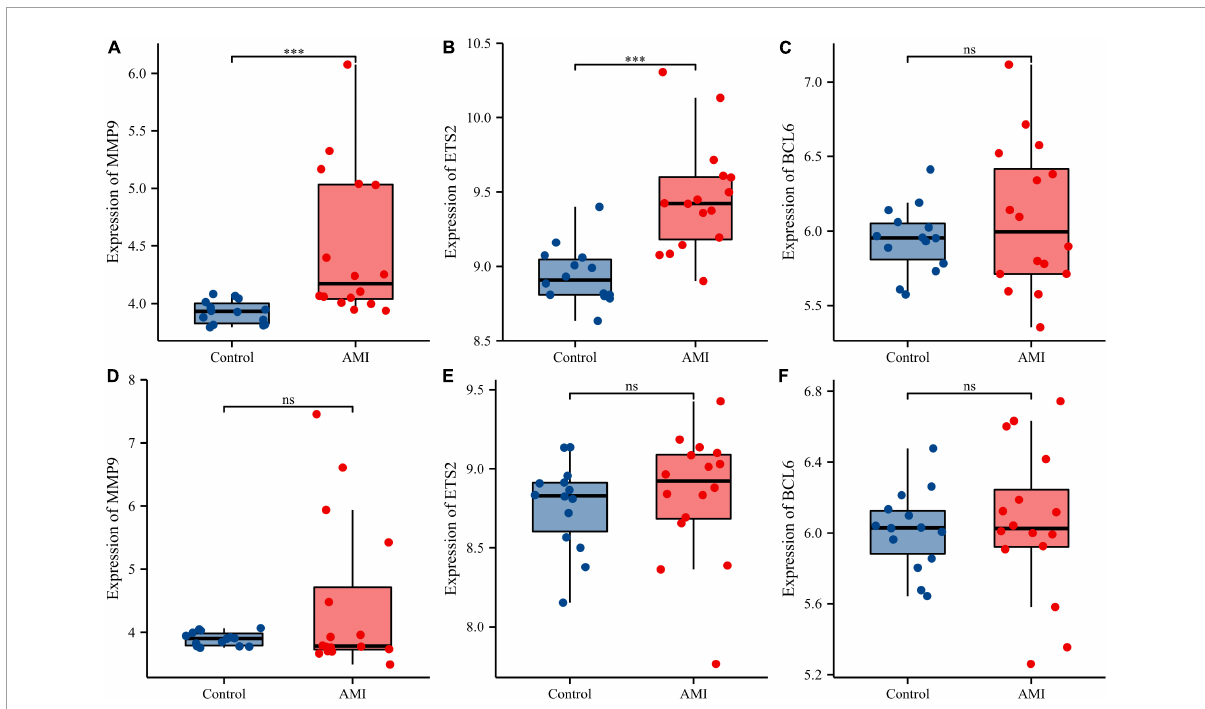
FIGURE13 Comparison of the expressions of three diagnostic genes in the GSE19322 dataset. Expression levels of MMP9 (A) , ETS2 (B) , and BCL6 (C) at 1 day after AMI; expression levels of MMP9 (D) , ETS2 (E) , and BCL6 (F) at 5 days after AMI. ns, no significance; ∗∗∗ p < 0.001.